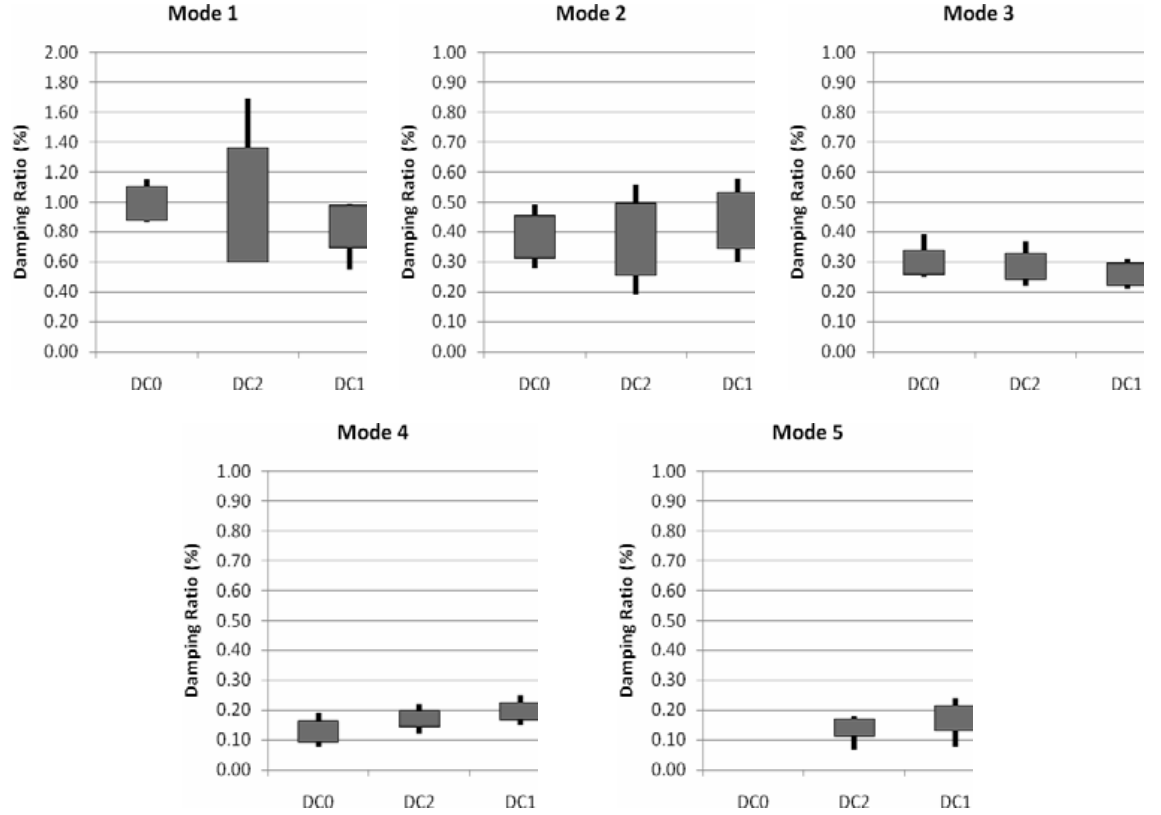
Fig. 14. Evolution of identified damping ratios due to damage (FDD) ; solid bars signify µ ± σ range and error bars signify minimum and maximum